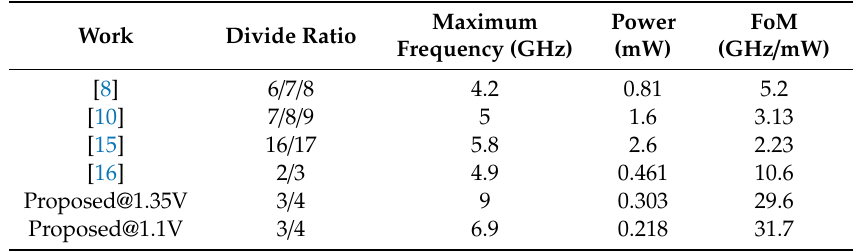
Table 3. Measurement performance.